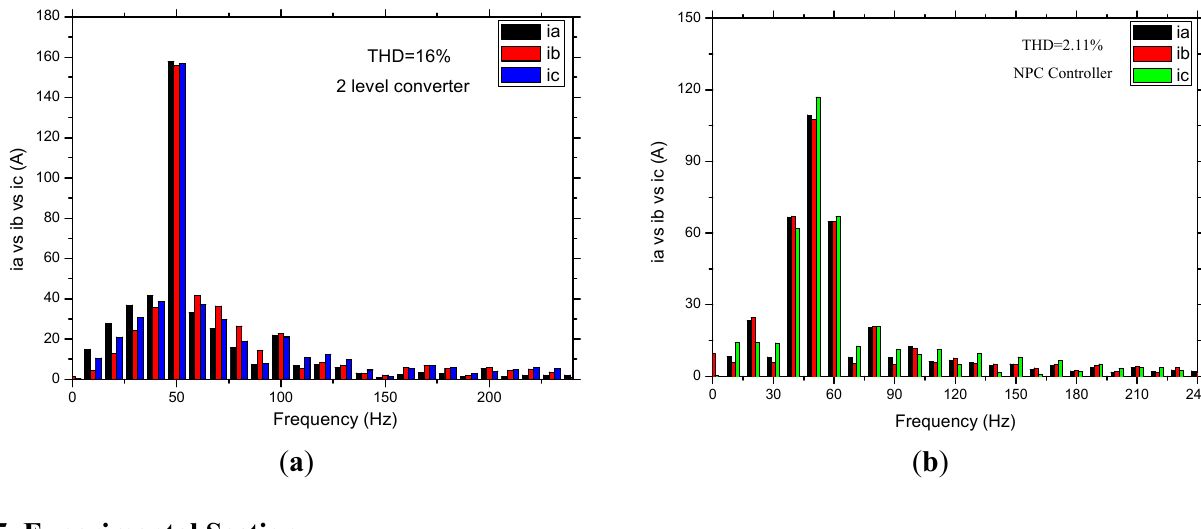
Figure 7. Harmonic distribution of the ( a ) three-level NPC-VSC converter and ( b ) two-level converter.